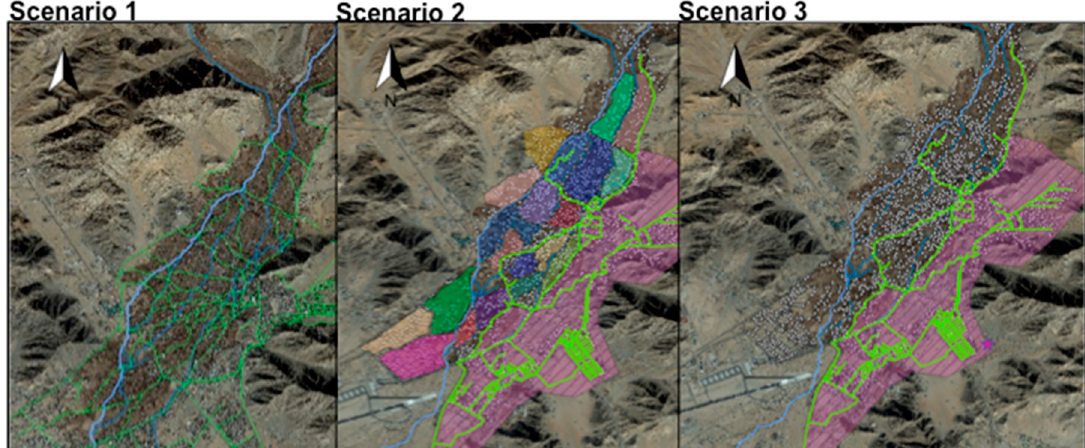
Figure 1. Three scenarios for water reclamation with resource recovery in Leh, India.